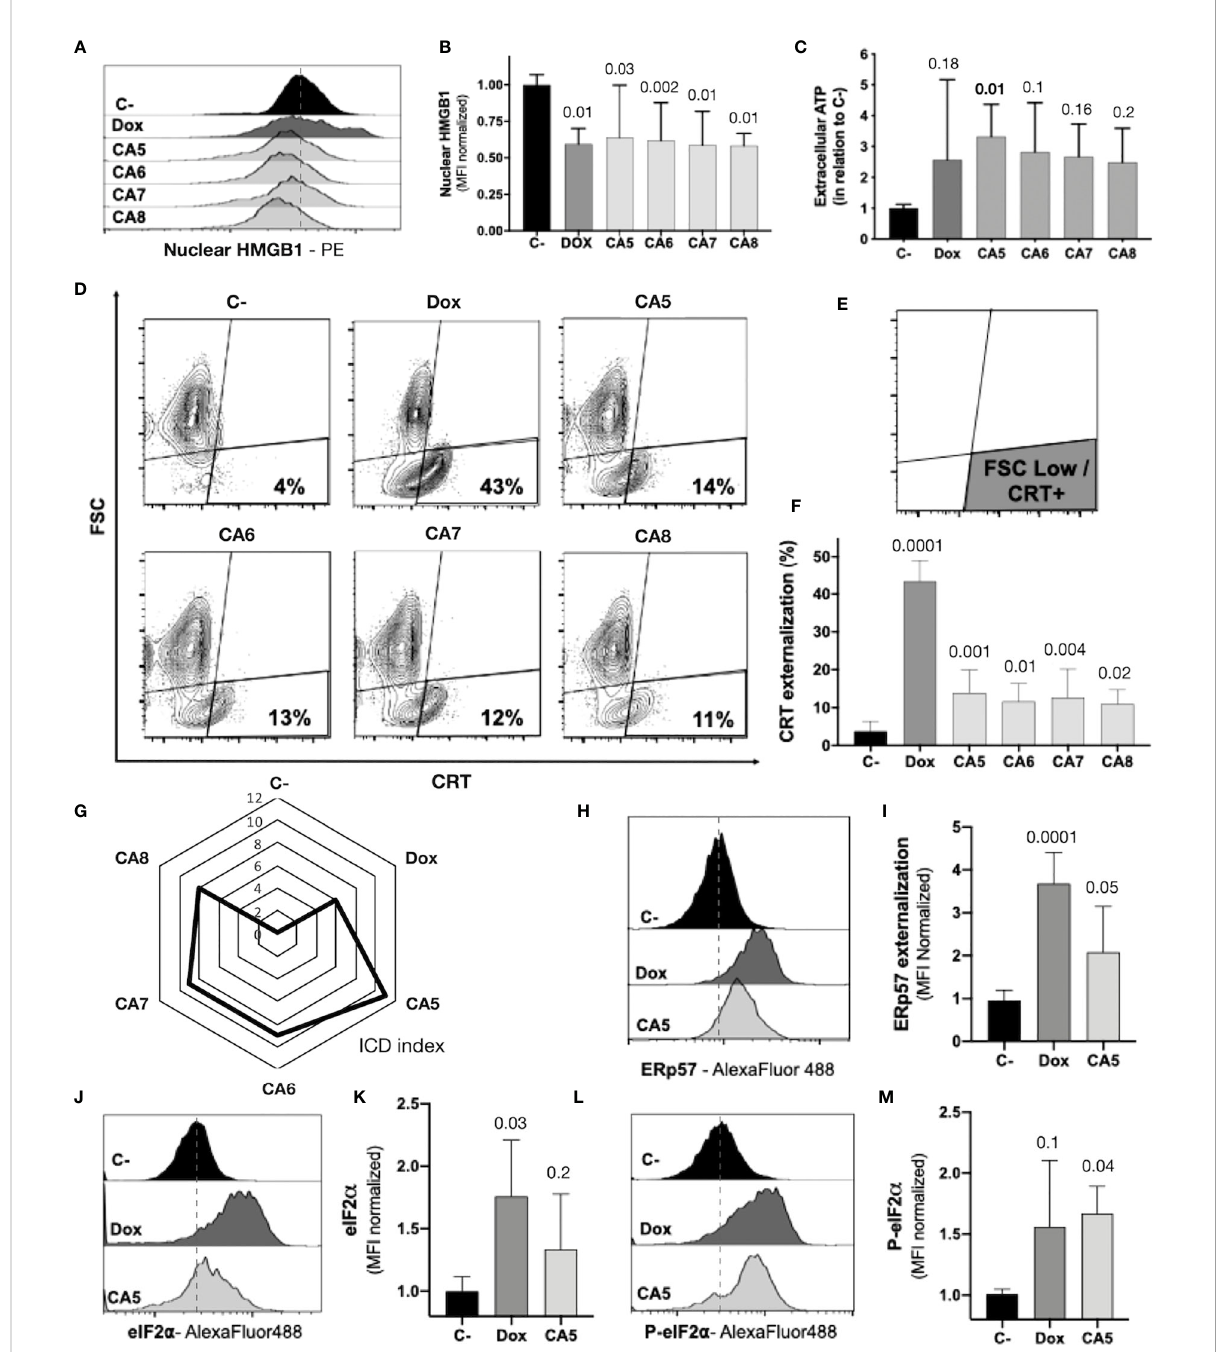
FIGURE 4 Chromomycins A 5-8 induce the release of immunogenic cell death DAMPs. B16-F10 melanoma cells were treated with DMSO (C-), as a negative control, doxorubicin (Dox), as a positive control, and CA 5-8 (CA5-8) for 24 h. (A) Representative histograms of nuclear HMGB1 evaluated by fl ow cytometry and (B) graph depicting normalized median fl uorescence intensity (MFI) of nuclear HMGB1. (C) Normalized extracellular ATP levels measured by luminescence. (D) Representative contour plot graphs of calreticulin (CRT) vs cell size (forward scatter, FSC) by fl ow cytometry, (E) Illustration of the gated region of CRT+ cells with low FSC and (F) graph depicting the percentage of CRT+ cells. (G) Radar graph of the index of immunogenic cell death (ICD index). Details of ICD index are described in SI.2. (H) Representative histograms of ERp57 evaluated by fl ow cytometry and (I) graph depicting normalized MFI of ERp57. (J) Representative histograms of eIF2 a evaluated by fl ow cytometry and (K) , graph depicting normalized MFI of eIF2a. (L) Representative histograms of cells with eIF2 a phosphorylated at serine 51 (P-eIF2 a ) evaluated by fl ow cytometry and (M) graph depicting normalized MFI of P-eIF2a. Data presented in graphs as mean ± standard deviation of 3 independent experiments performed in triplicate. The p values of C- compared to the treated groups are above each treated